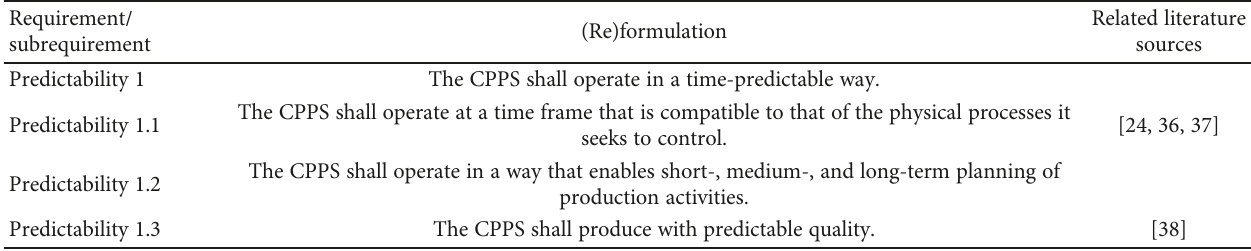
Table 4: Synthesis and reformulation of requirements on predictability.